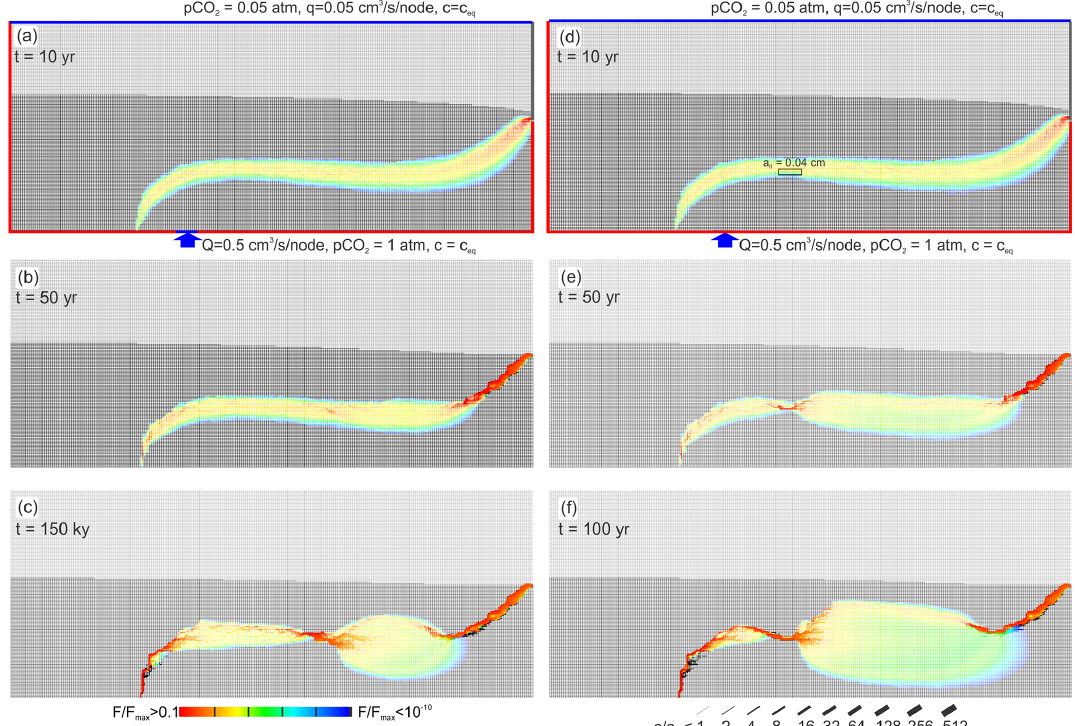
Figure 16. Evolution of mixing zone instability and constriction. (a–c) Standard case (see Fig. 4); (d–f) : standard case, where instability was triggered by assigning the initial aperture a 0 = 0 . 04cm to a set of four horizontal fractures, marked by rectangle in (d)